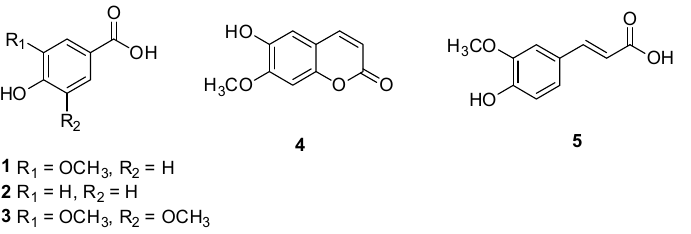
Figure 3. Chemical structures of compounds 1–6 : vanillic acid ( 1 ), 4-hydroxy-benzoic acid ( 2 ), syringic acid ( 3 ), isoscopoletin ( 4 ), and ( E )-ferulic acid ( 5 ).